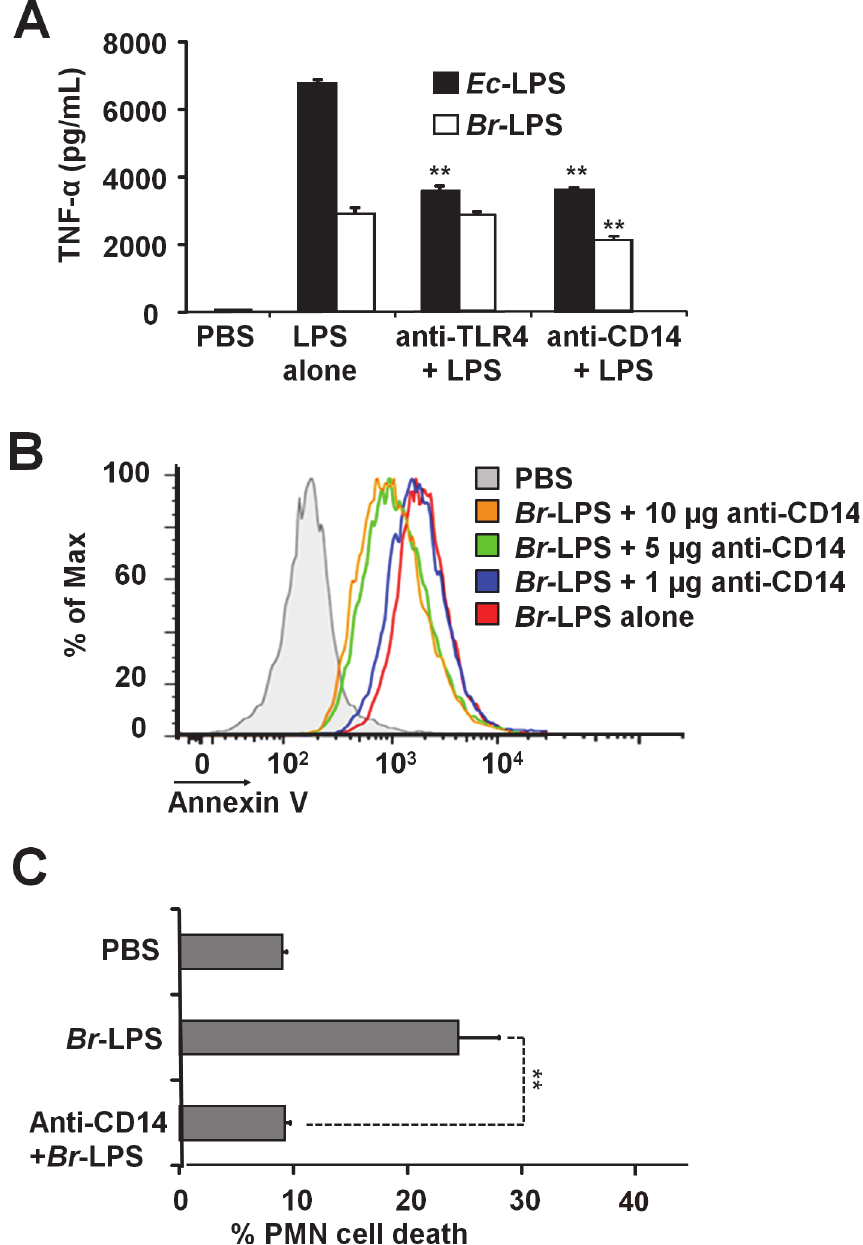
Fig 9. Neutralization of CD14 protects against Br- LPS-induced PMN cell death. (A) Heparinized blood was incubated for two hours with 0.4 pmol/mL of Ec- LPS or 3 pmol/mL of Br- LPS. Prior to LPS stimulation, some samples were previously treated with anti-TLR4 (1 μ g/mL) or anti-CD14 (5 μ g/mL) antibodies and TNF- α secretion quantified in plasma by ELISA. Values of p < 0.01 ( ** ) are indicated in relation to their respective LPS control. (B) Heparinized blood was incubated with Br- LPS (3 pmol/mL) alone or previously neutralized with different quantities of anti-CD14. PMN population was gated and analyzed by Annexin V marker. Geometric means of histograms displayed as relative units. Experiments were repeated at least three times. (C) Purified PMNs were incubated for two hours with Br- LPS (1.5 pmol/mL). Prior to LPS stimulation, some samples were previously treated with anti-CD14 (5 μ g/mL) antibodies and PMN population gated and analyzed by AquaDead marker. Anti-CD14 alone does not have any significant effect in PMN cell death. Value of p < 0.01 ( ** ) is indicated in relation to the Br -LPS